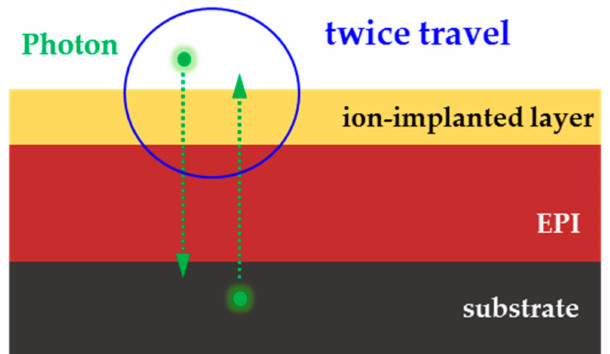
Figure 9. The schematic of the twice travel of photons excited from the substrate.